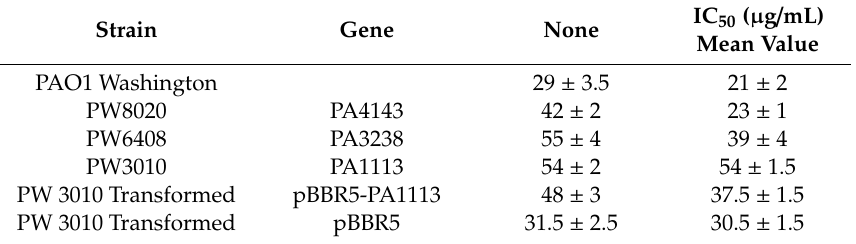
Table 2. Effects of verapamil on the sensitivity of P. aeruginosa PAO1 and its mutants to carbenicillin.